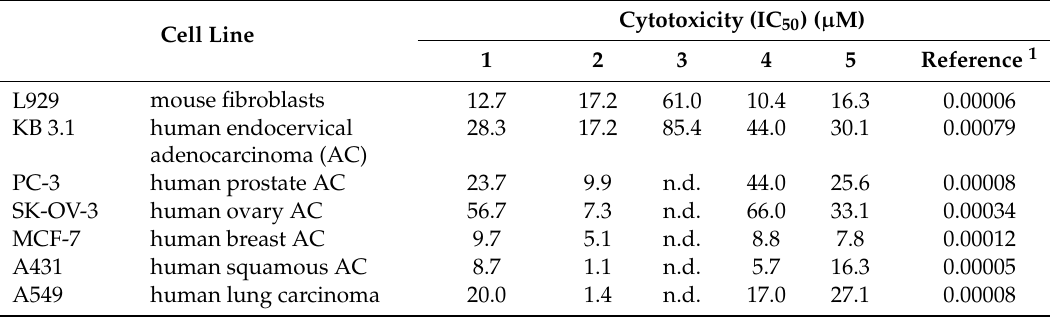
Table 3. Cytotoxicity of 1 − 5 against mammalian cell lines as half-maximum inhibitory concentrations (IC 50 ). n.d.: not